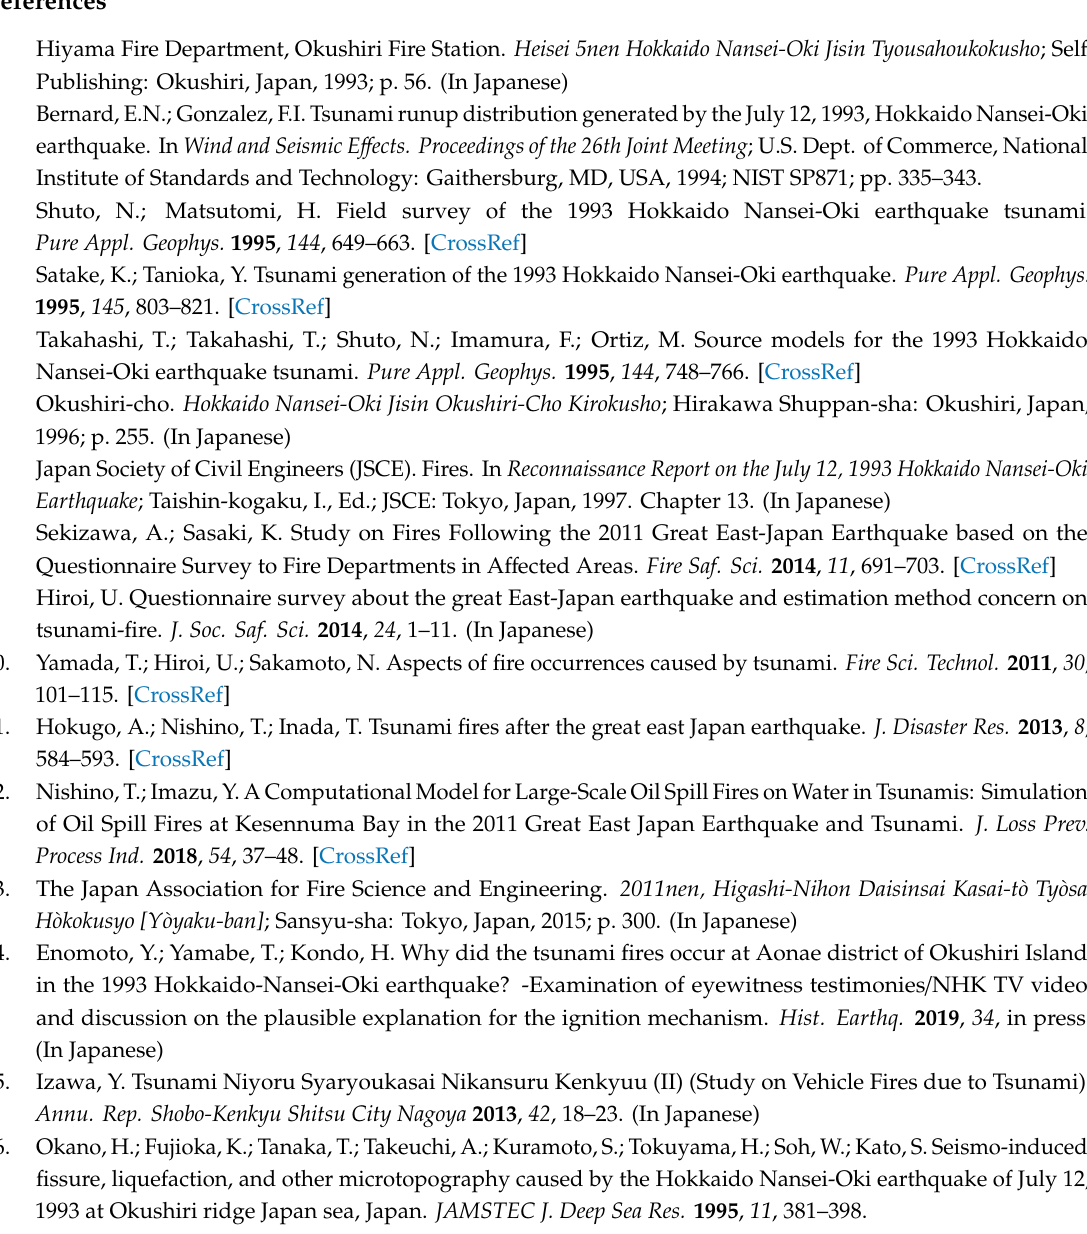
Figure A2. Wooden print ( Nishikie ) of the 1896 Meiji-Sanriku tsunami by M. Kokuni. (Holding of Y. Enomoto).